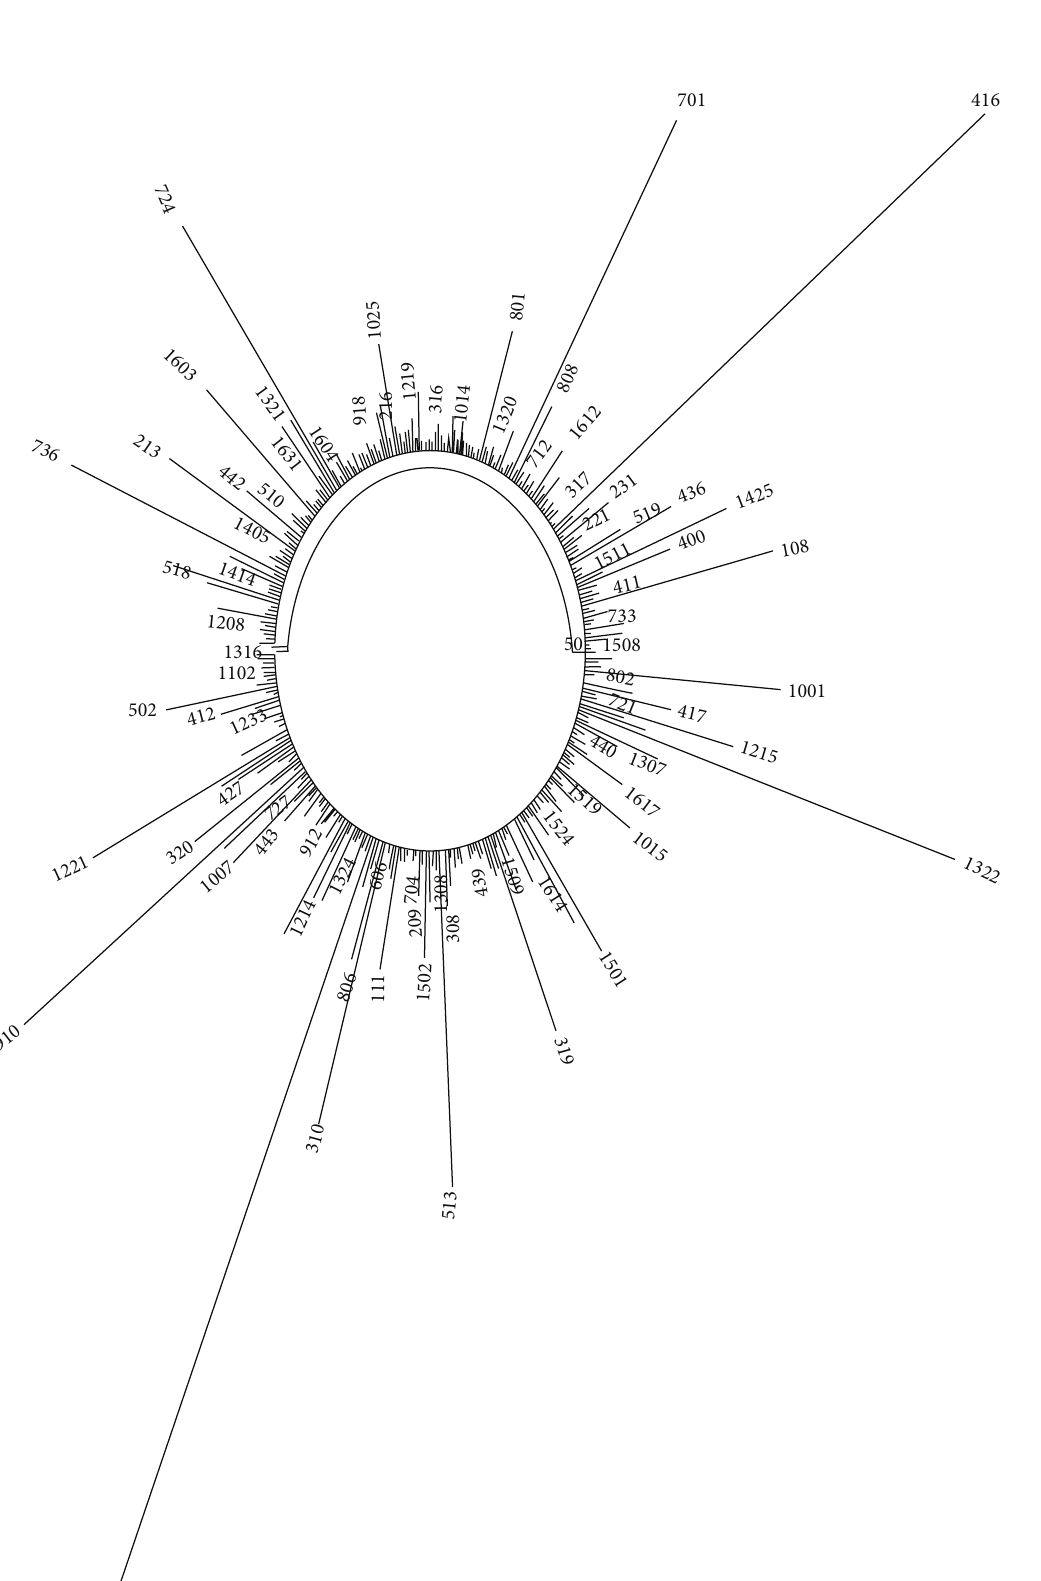
Figure 10: Phylogenetic analysis of the S. cerevisiae ARS. Phylogenetic tree constructed by using the neighbourhood joining